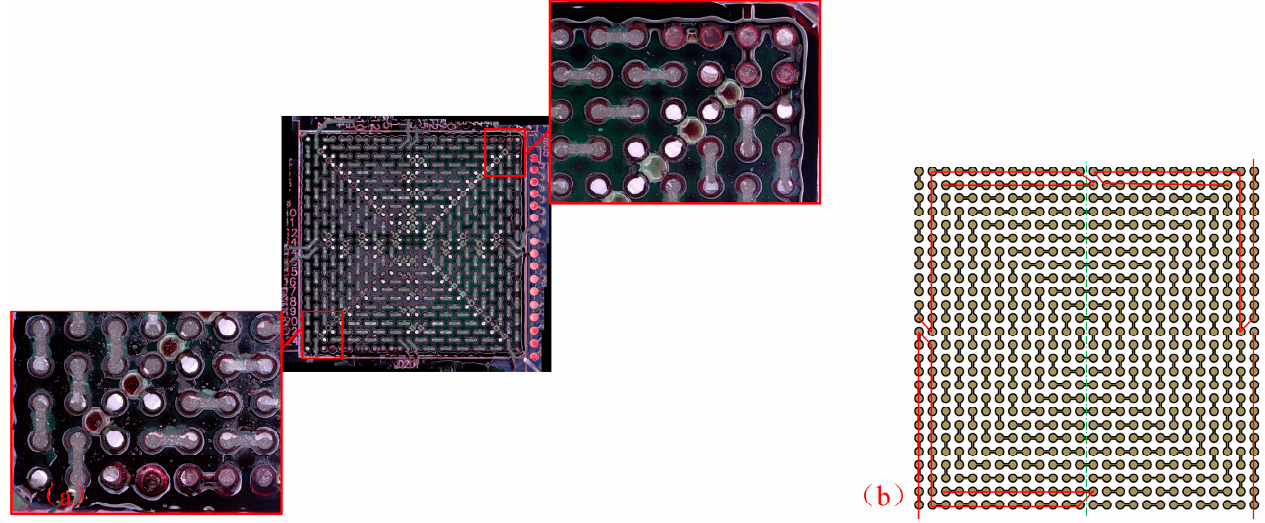
Figure 17. The combined temperature cycling and random vibration tests results in D101: ( a ) dye and pry test results; ( b ) typical solder joint failure locations.